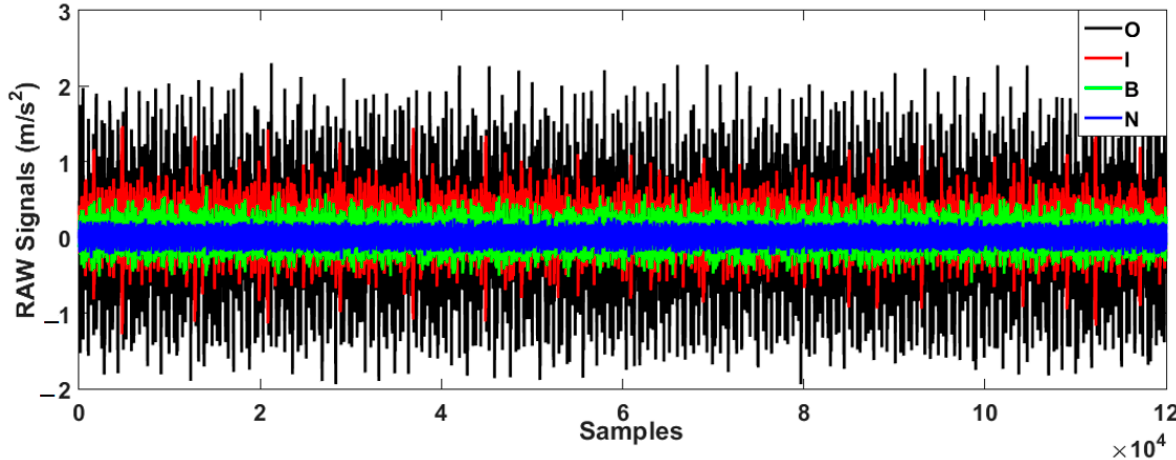
Figure 2. Raw vibration bearing signals in normal and abnormal conditions.